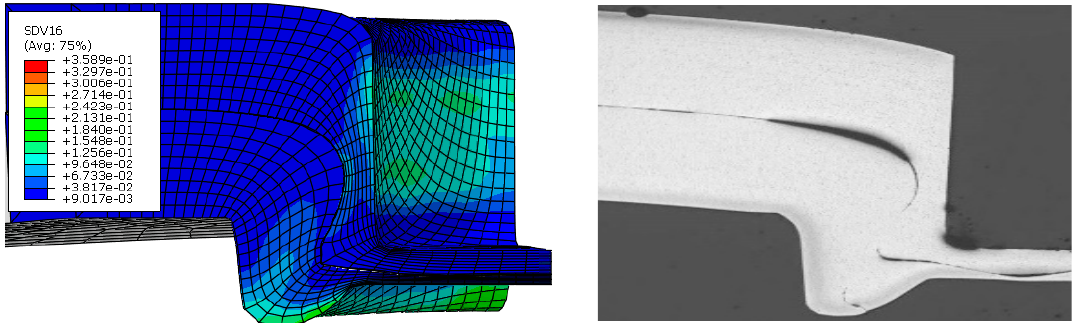
Figure 9. The damage parameter (SDV16).